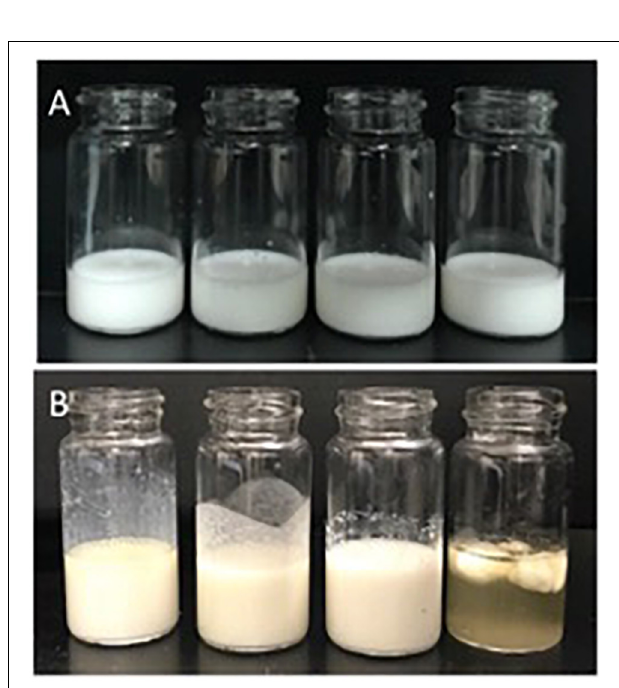
FIGURE 4 | Emulsion appearance before (A) and after (B) 2-h exposure to SGF. From left to right: LS, LU, SS, and SU. LS, liquid lipid-acid stable emulsifier; LU, liquid lipid-acid unstable emulsifier; SS, solid lipid-acid stable emulsifier; SU, solid lipid-acid unstable emulsifier; SGF, simulated gastric